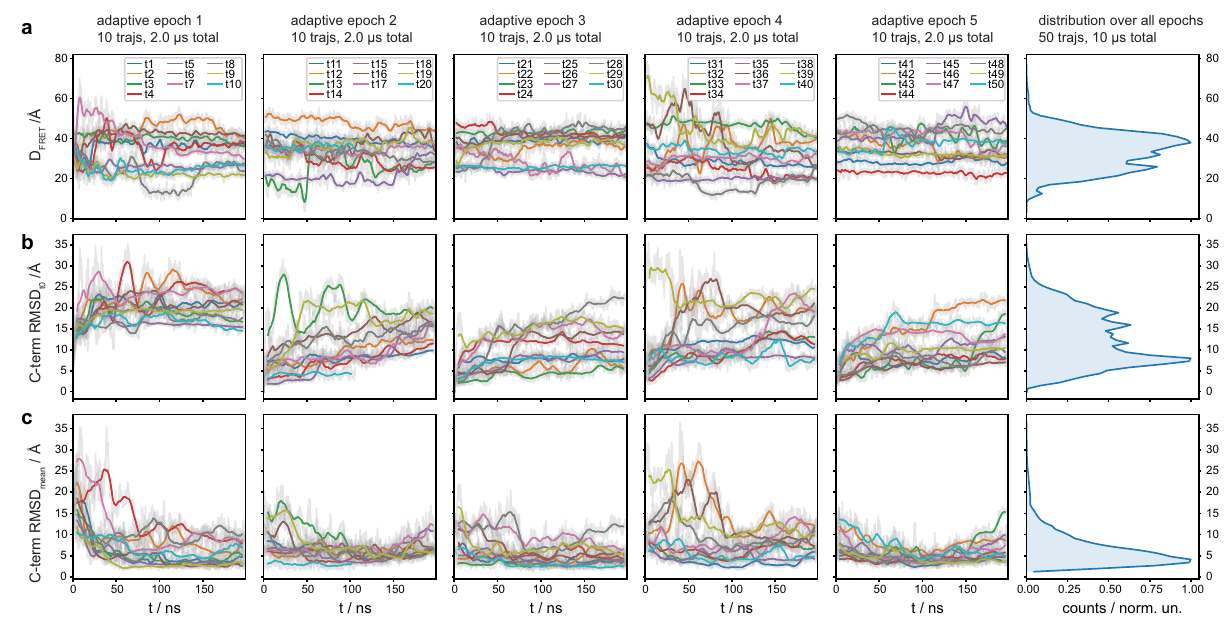
Fig. 6 | The fl exibility of the β 2AR CT observed in MD simulations. a – c The ofAngstrom(e.g.thegreencurveofthesecondepoch,trajectory13). b Root-mean- fl exibility ofthe β square-deviation (RMSD) of the CT backbone atoms, monitoring the structural 2 ARCT observedin MD simulations and the related histogram of changes of the CT with respect to each trajectory ’ s starting frame. Strikingly, The all the values of the CT fl uctuations around each trajectory ’ s average structures. CT moves away quickly from the modeled starting conformation by up to 30 Å in The fi rst fi ve columns represent the fi ve adaptive sampling epochs, each epoch the fi rst epoch. The disordered nature of CT is re fl ected by the high variability of consisting of ten individual, unbiased, 200ns long MD trajectories of the β 2 AR. Each row shows the time traces for different geometrical parameters. a Minimum differentconformationssampledinallepochs. c RMSDof theCTbackboneatoms, distancebetweenCYS148and CYS378heavy-atoms, tracking the distancebetween monitoring the fl uctuations of the CT around the trajectory ’ s average structure. dyes in the smFRET experiments. This parameter was used as the “ exploit ” com- Thewiderange ofvalueshintsatarather fl atfree-energylandscape underlyingthe ponent in the adaptive sampling. We observe a high range of distances sampled in dynamics, which is characteristic of structurally disordered proteins. Time-traces all 50 trajectories, indicating a high structural fl exibility of CT in the nanosecond show the running-averages as solid lines (smoothing window of 50ns) overlaid on timescale: Only in a few trajectories does the CYS-CYS distance remain constant topoftherawtime-trace,showningrayinthebackground.Thedistributionsonthe (e.g.theredcurveinthelastepoch,trajectory44).Inmostcases,itchangesbytens rightermost panels are computed using the raw